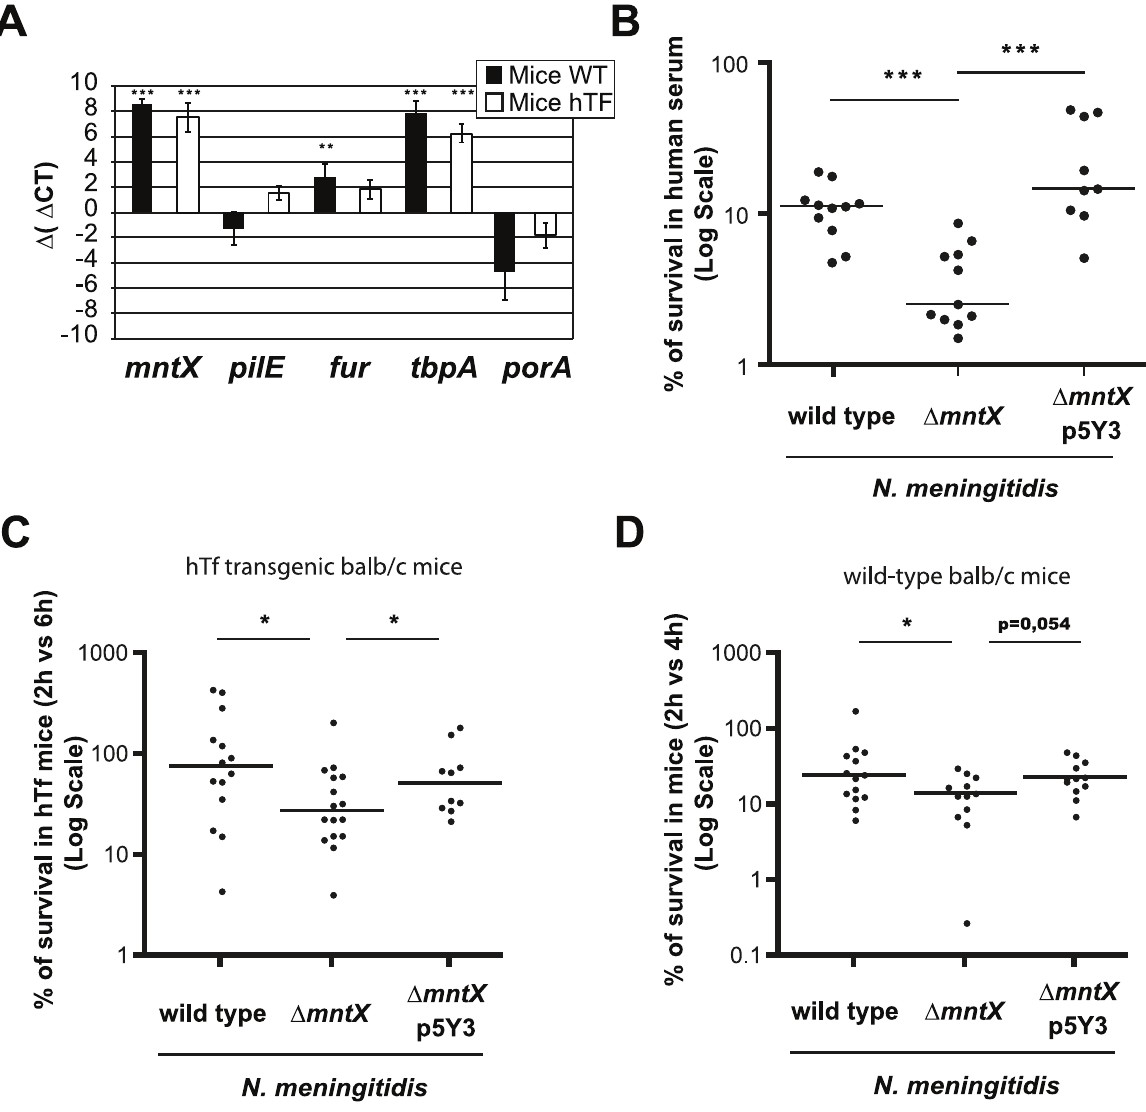
hTf mice and Figure 7D for wild type mice. Median survival of